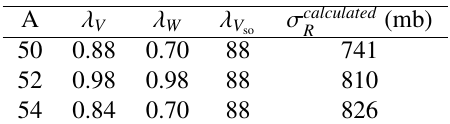
Table 1. Best fit values of renormalization constants for real and imaginary parts of the central ( λ V and λ W ) and real spin-orbit ) potentials, for protons of 65 MeV elastic scattering from ( λ V so stable even Cr isotopes. The corresponding total reaction cross sections ( σ R ) are also given.